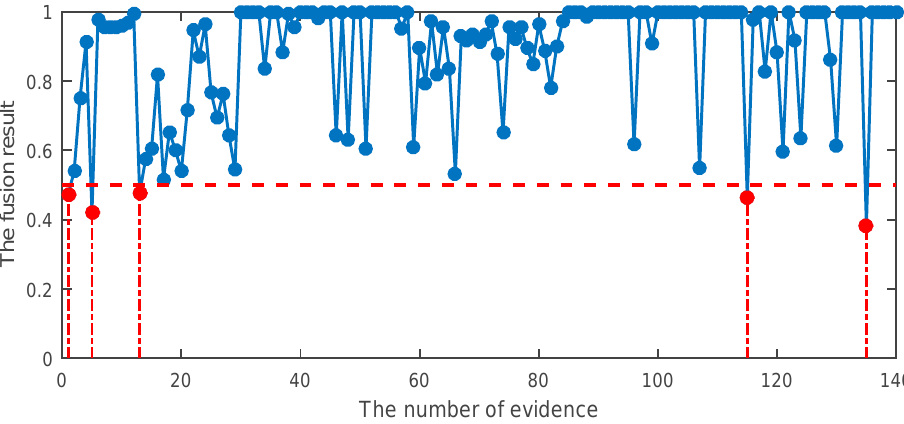
Figure 15. The fusion result using HCE with DST given in reference [25].